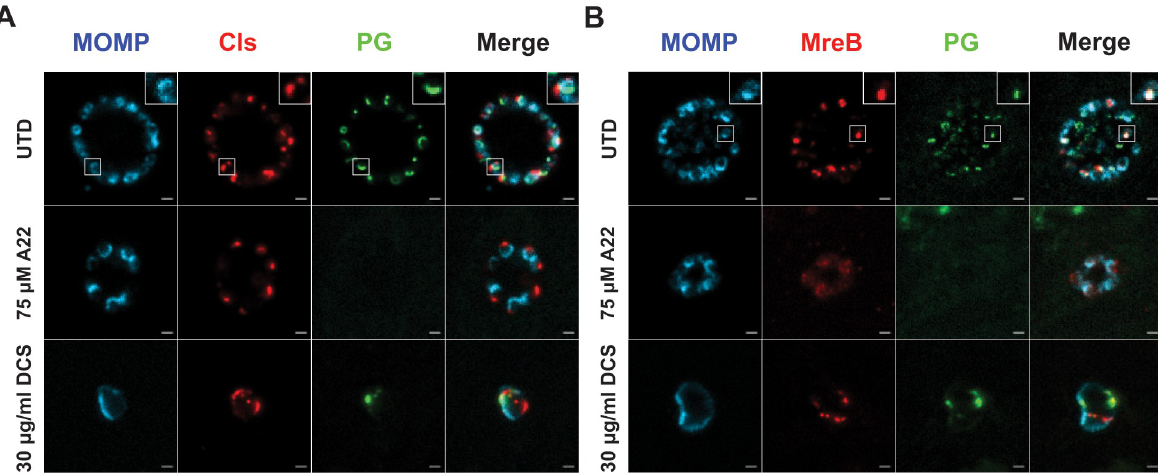
Fig 6. Effect of cell division inhibitors on localization of (A) Cls_6xH (labeled Cls) and (B) MreB_6xH (labeled MreB). Cells were infected with transformants carrying anhydrotetracycline (aTc) inducible vectors encoding the indicated constructs. Expression of Cls_6xH or MreB_6xH was induced at 16 hpi, and cells were fixed and processed for immunofluorescence at 20 hpi. To visualize peptidoglycan (PG), cells were incubated with EDA-DA during the infection and processed using click-iT reagents as described in the Materials and Methods. To assess effects of disrupting the central coordinator of chlamydial cell division, MreB, the antibiotic A22 was added at 18hpi whereas peptidoglycan synthesis was disrupted using D- cycloserine (DCS) added at 4hpi. Note the continued presence of Cls_6xH at a discrete site on the bacteria under all conditions tested. The insets within the upper row images are a zoomed-in view of the boxed regions in the larger image. Images were acquired on a Zeiss AxioImager.Z2 equipped with an Apotome2 using a 100X lens objective. Images are representative of at least three independent experiments. Scalebar = 2 μ m.